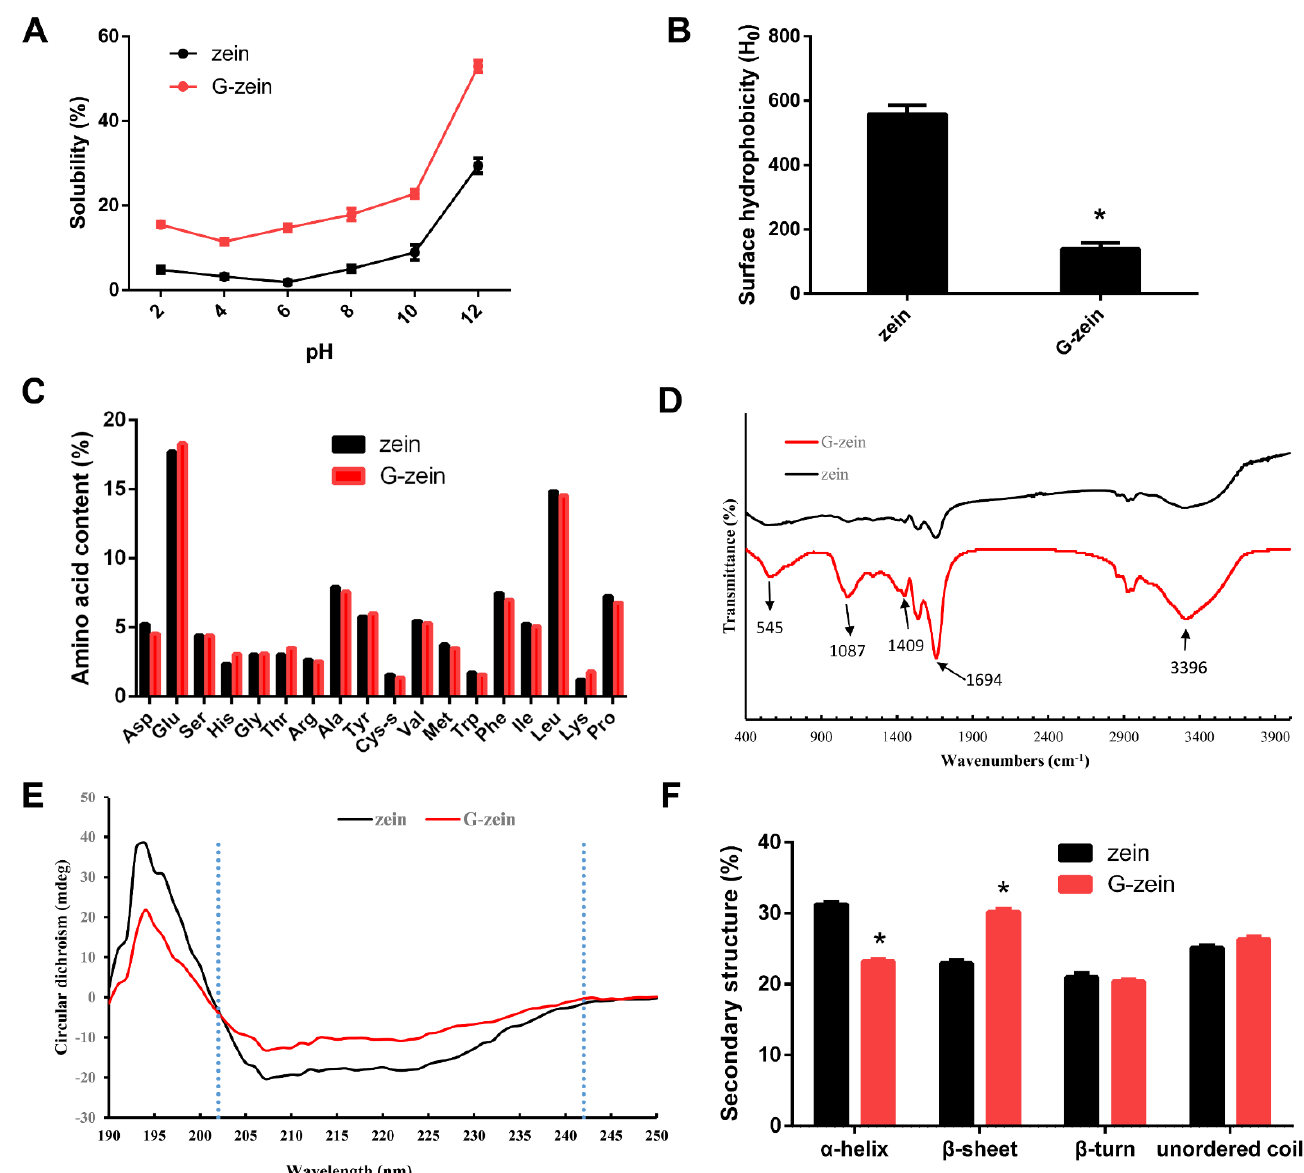
Figure 2. Characterization of zein and G-zein. ( A ) Changes in solubility of zein and G-zein with pH. ( B ) Surface hydrophobicity of zein and G-zein. ( C ) Amino acid composition of zein and G-zein. ( D ) Fourier transform infrared spectroscopy, ( E ) circular dichroism, and ( F ) secondary structure of zein and G-zein. * p < 0.05 compared to control.